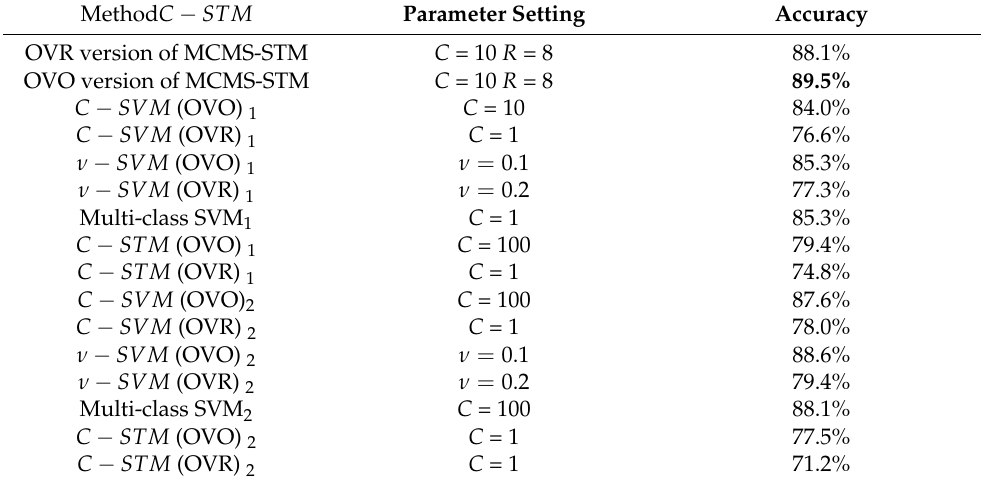
Table 4. The accuracies of different methods for multiscale airplanes recognization using 10-fold